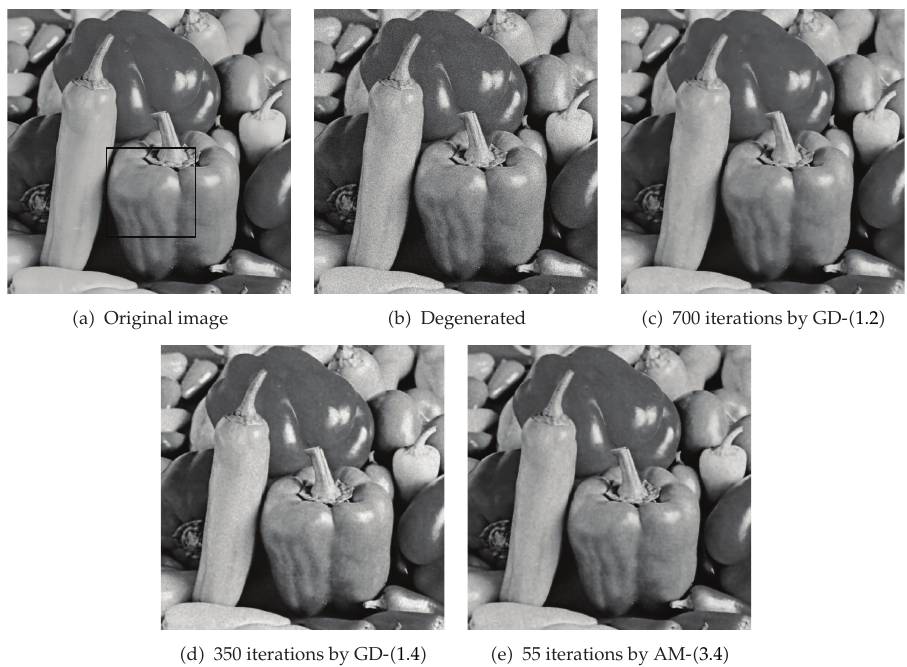
Figure 3: Recovered results of di ff erent models by di ff erent numerical